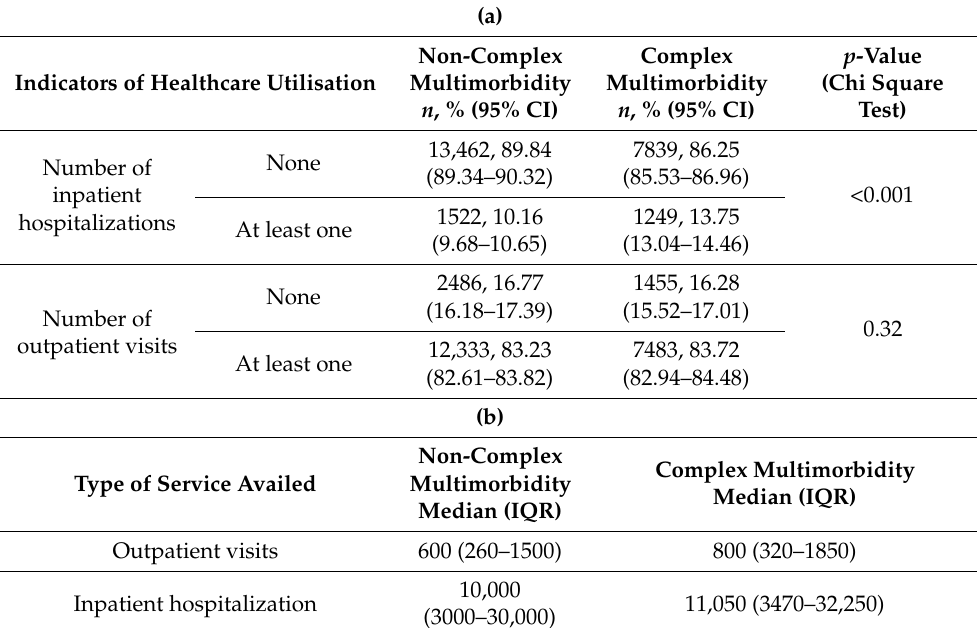
Table 4. ( a ) Association of selected indicators of healthcare utilisation with multimorbidity vs. complex multimorbidity among study population. ( b ) Healthcare expenditure in